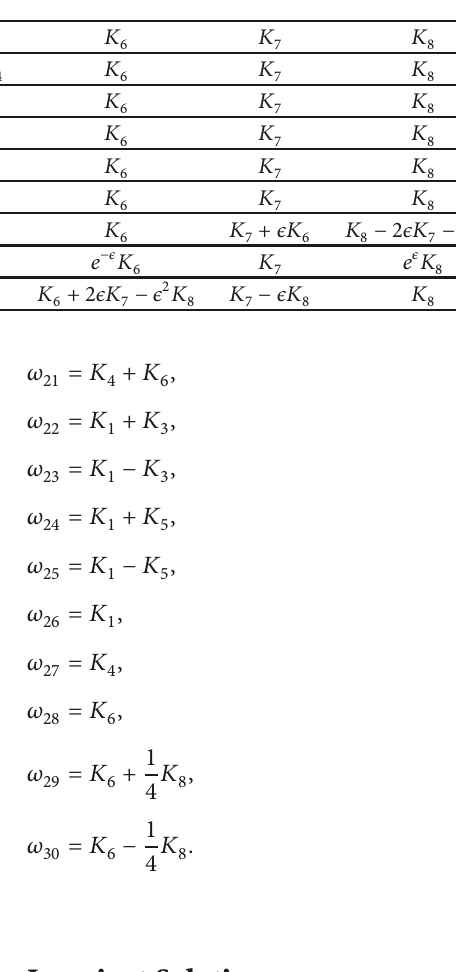
Table 2: Adjoint representation table of G .